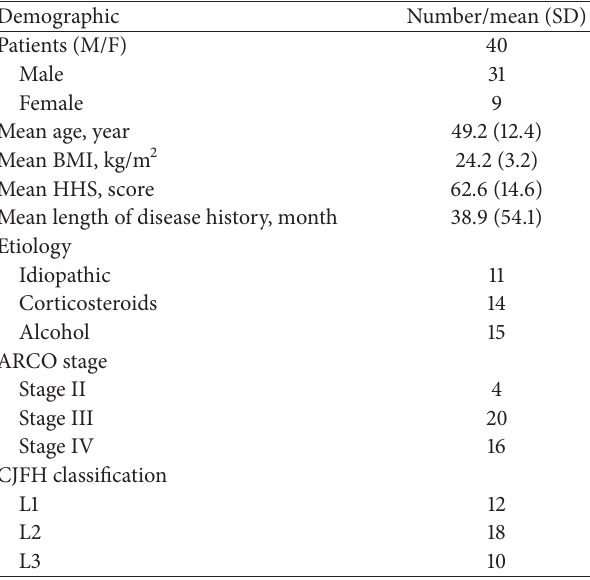
Table 1: The demographics of patients with